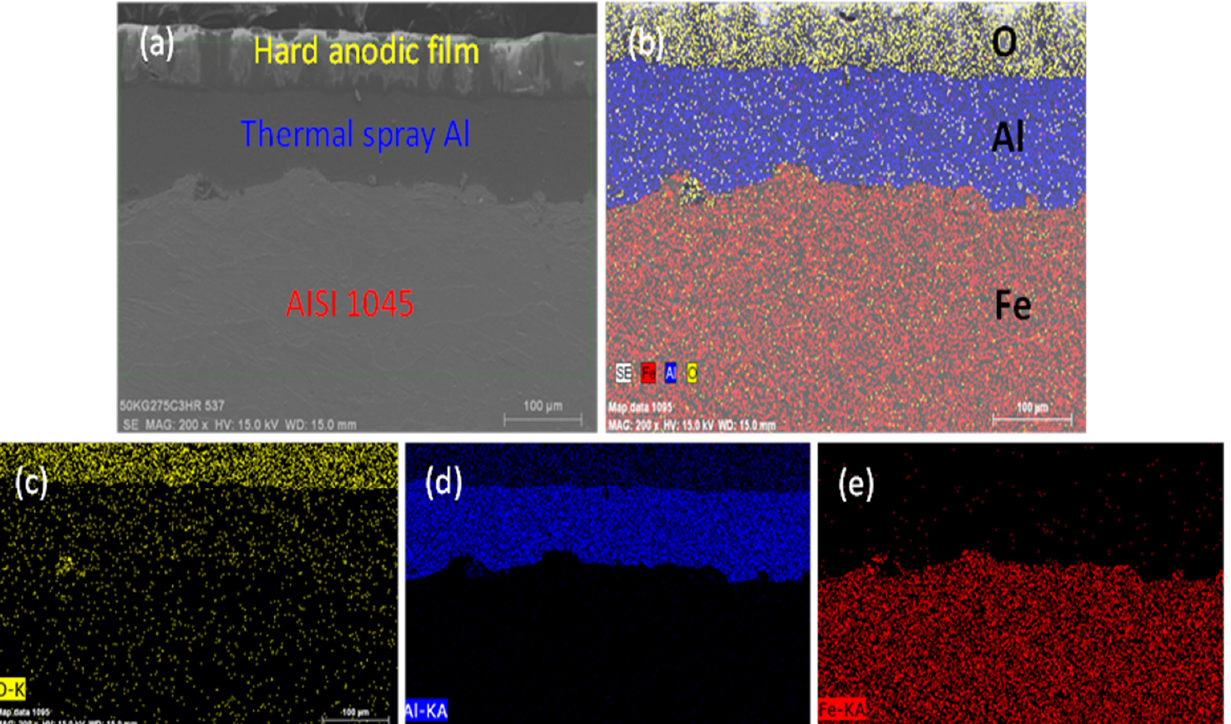
Figure 12. SEM Images of AISI 1045/thermally sprayed Al/hard anodic film interfaces; ( a ) hard anodic film on thermally sprayed Al/AISI 1045, ( b ) SEM mapping of AISI 1045/thermally sprayed Al/hard anodic film with ( c ) O mapping, ( d ) Al mapping, and ( e ) Fe mapping, respectively.